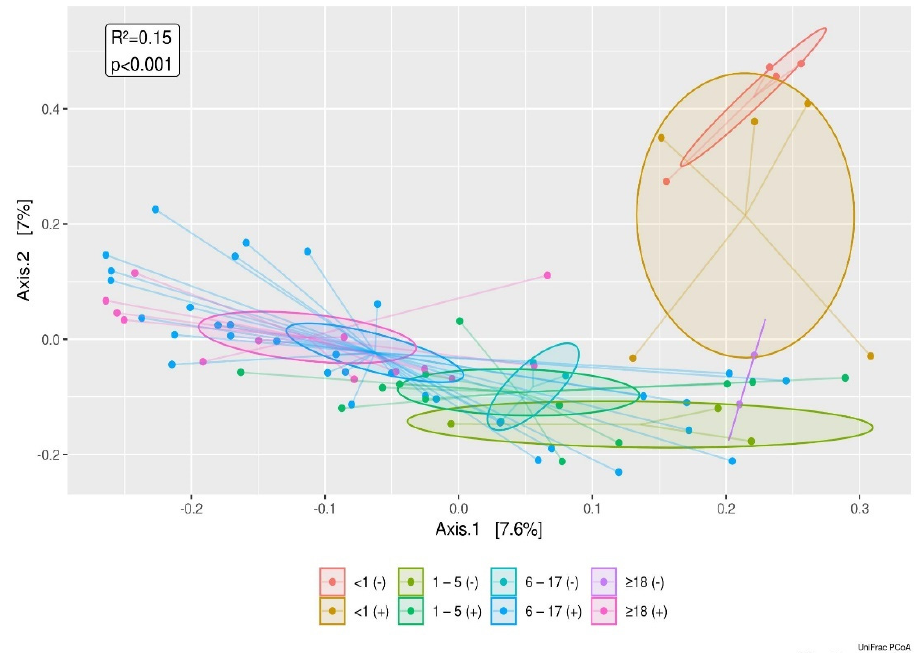
Figure 4. The UniFrac distances between enteric pathogen positive versus enteric pathogen negative subjects is displayed by age groups, using principal coordinate analysis (PCoA). The infant group tends to separate out according to Axis 1 (7.6%) and Axis 2 component (7%). The differences of the infant group from other age groups as shown in Figure 1, are also confirmed for comparisons of enteric pathogen negative versus enteric pathogen positive subjects.